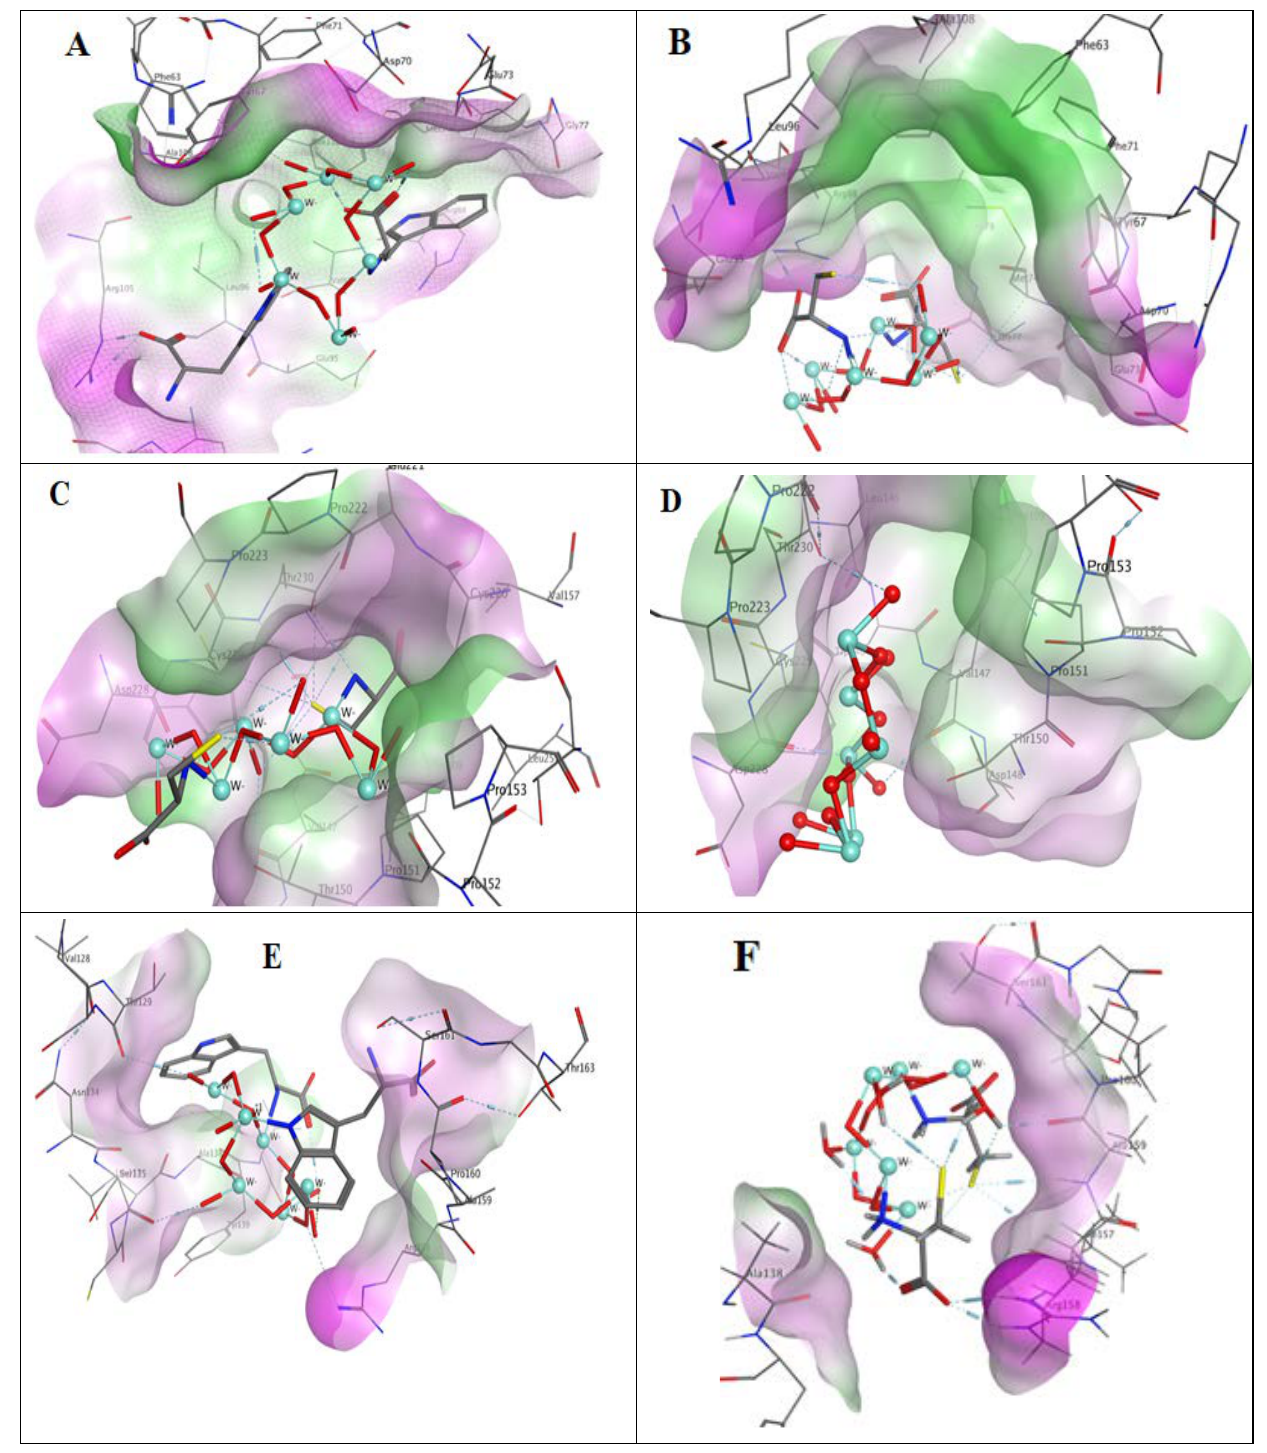
Figure 8. 3D interaction of ( A ) WO 3 -Trp nanocomposite with Bcl-2 protein, ( B ) WO 3 -Cys nanocomposite with Bcl-2 protein, ( C ) WO 3 -Trp nanocomposite with p53 protein, ( D ) WO 3 NPs with p53 protein, ( E ) WO 3 -Trp nanocomposite with E2F2 protein, ( F ) WO 3 -Cys nanocomposite with E2F2 protein.